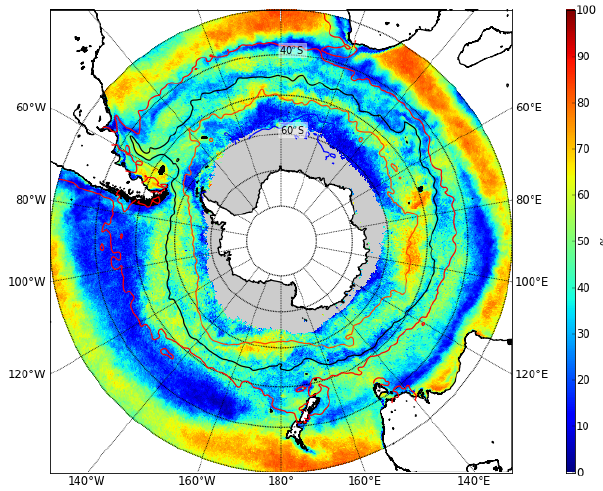
Fig. 4. Percentage (from 0 to 1) of the overall variance explained by the mean seasonal cycle for the Southern Ocean south of 30 ◦ S. Masked grid-points in white correspond to areas where more than half of the weekly values are missing. Mean (1998–2007) frontal positions are shown for the STF (red), the SAF (black), the PF (green) and the SACCF